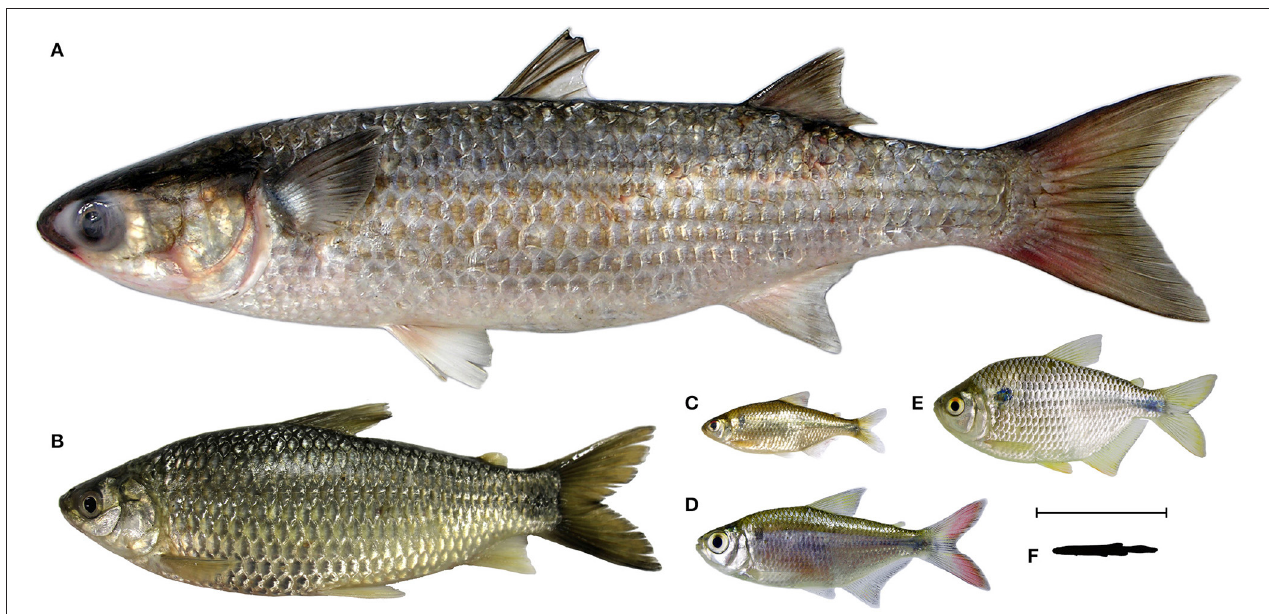
FIGURE 2 | Host species of Homodiaetus anisitsi represented in scale. (A) Mugil liza ; (B) Cyphocharax voga ; (C) Bryconamericus iheringii ; (D) Astyanax fasciatus ; (E) Astyanax jacuhiensis ; (F) Homodiaetus anisitsi represented in black. Scale bar 50mm.